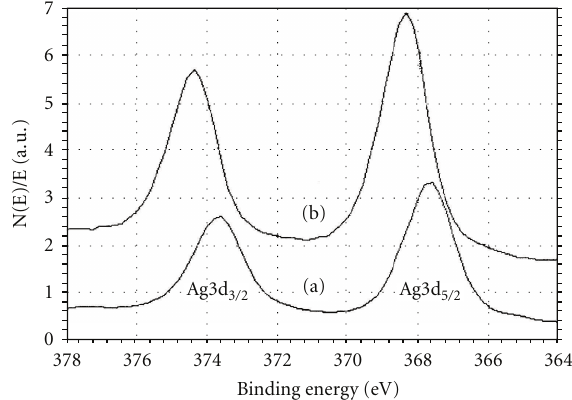
Figure 2: The XPS spectra of Ag3d 3 / 2 and Ag3d 5 / 2 from pure silver with native oxide (a) before sputtering and (b) after 1 h of argon ion sputtering.